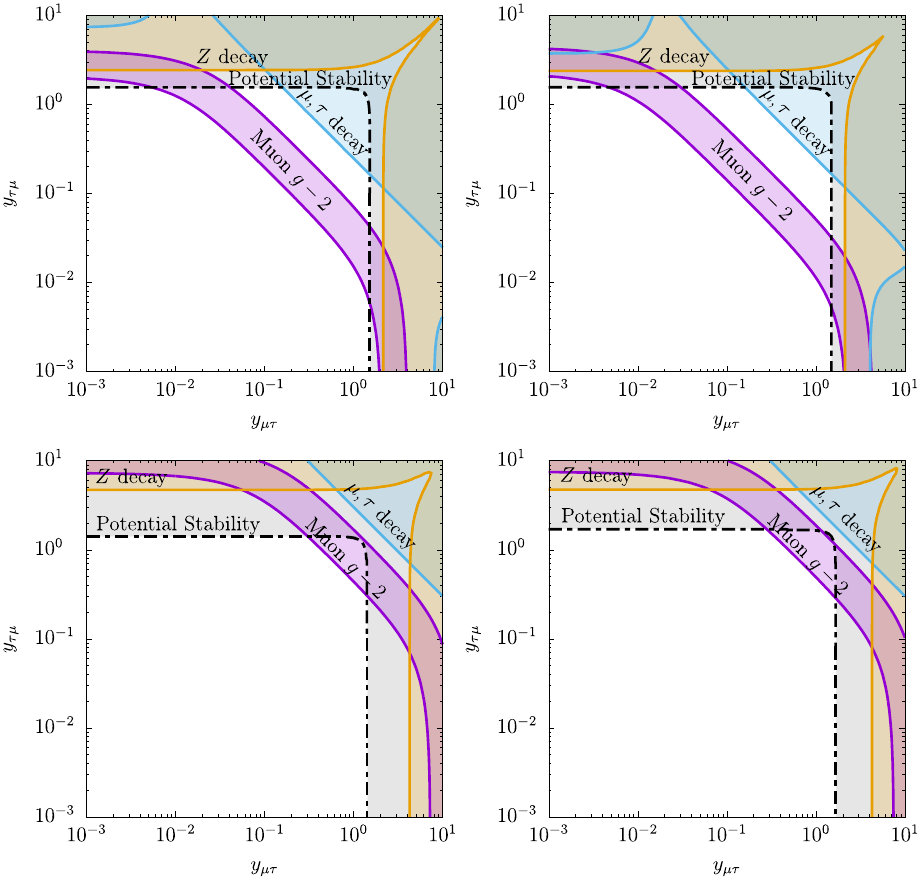
Figure 6 . Numerical analysis in ( y (cid:22)(cid:28) , y (cid:28)(cid:22) ) plane, where the charged scalar mass and the scalar quartic couplings ( m (cid:30) , (cid:21) 4 , (cid:21) 5 ) are (cid:12)xed as (200 GeV, 0 : 30, 0 : 40) on top right panel, (700 GeV, 0 : 01, (cid:0) 1 : 00) on bottom right panel, (cid:0)